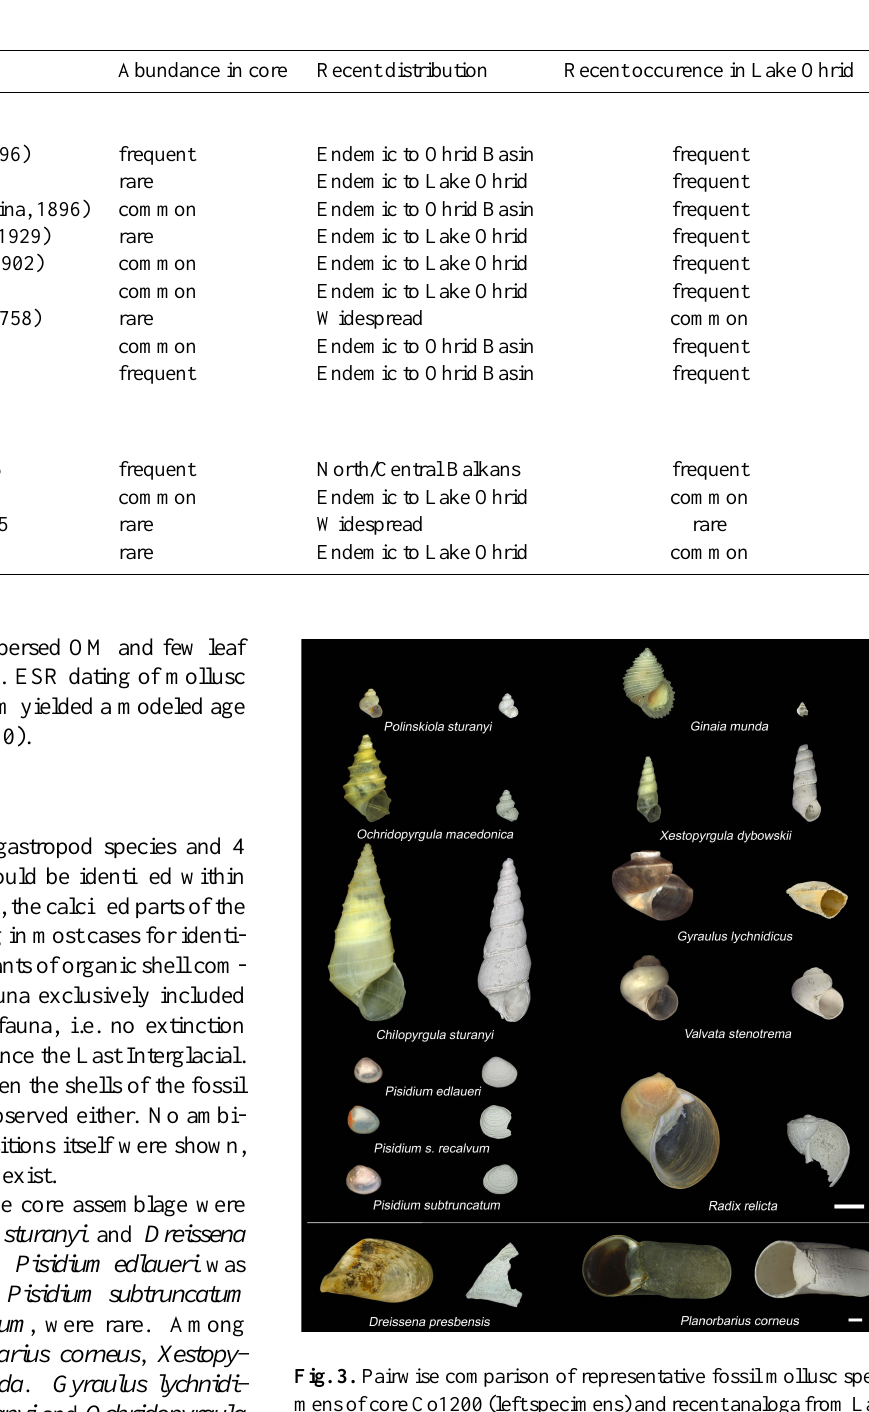
Table 1. List of mollusc taxa found in core Co1200. Semi-quantitative abundances of identifiable shell remains in the core, recent distribution, endemicity and abundance in Lake Ohrid are given. Fossil abundances: Less than 5 – rare, 5 to 50 – common, above frequent. For more details on recent occurrences of Gastropoda see Hauffe et al. (2010). Frequency of recent Bivalvia is according to Albrecht et al. (unpublished data).